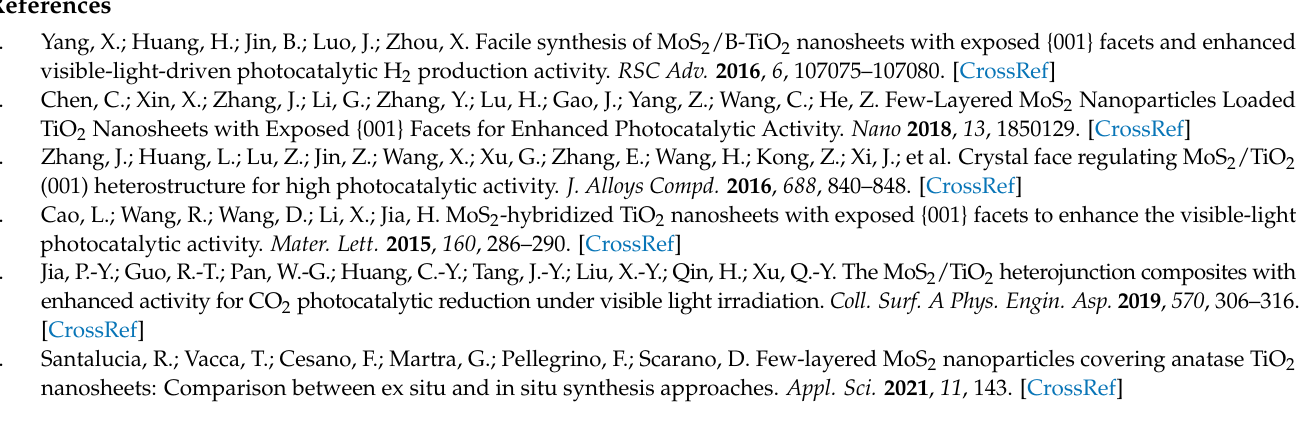
Figure S2: Phenol degradation profiles, expressed as the ratio between concentration after irradiation (C) and concentration before irradiation (C 0 ) of: (a) MoS 2 /TiO 2 bipy (red curve), (b) bipyramidal TiO 2 nanoparticles (light red curve), (c) MoS 2 /TiO 2 n-sh (blue curve), and (d) TiO 2